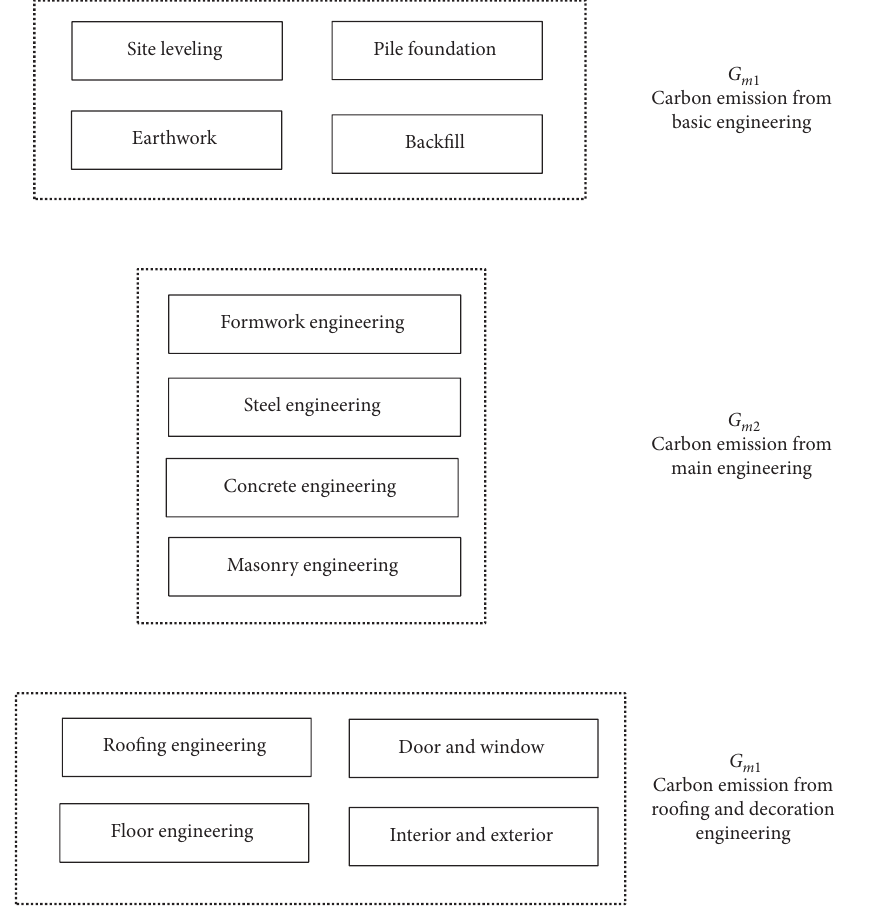
Figure 2: Carbon emission boundary